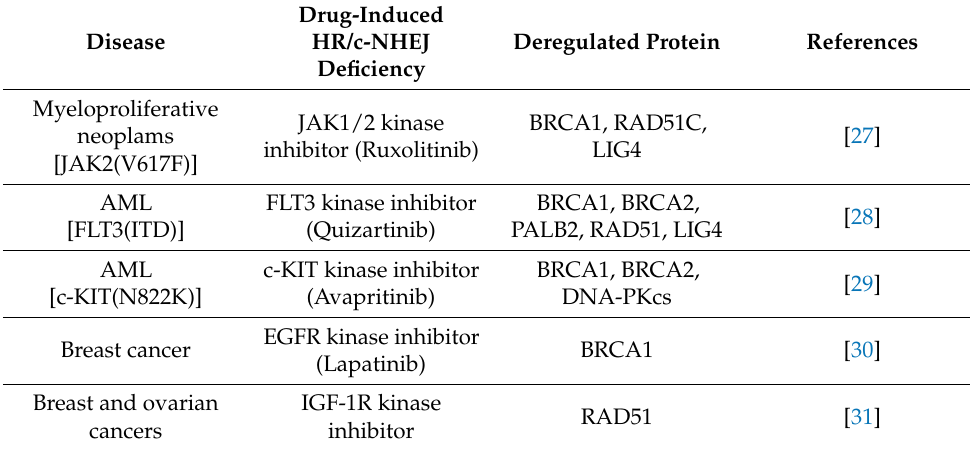
Table 2. Therapeutic drugs inducing HR/c-NHEJ